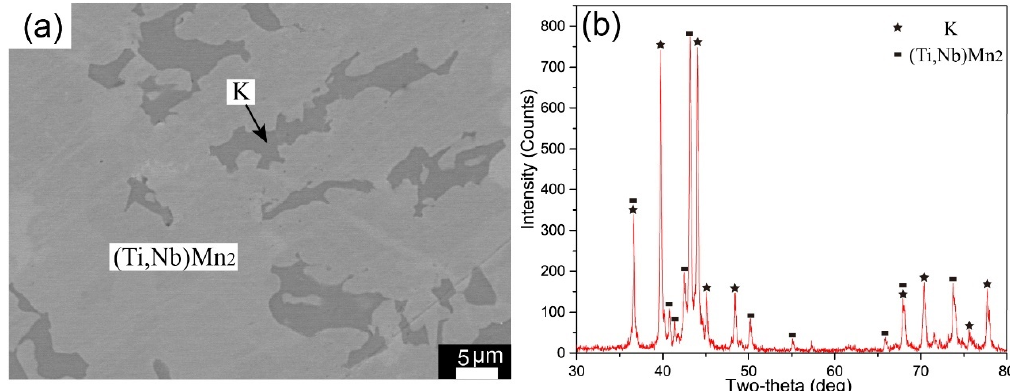
Figure 18. Alloy B8 annealed at 1273K for 60 days: ( a ) BSE images, ( b ) XRD patterns.